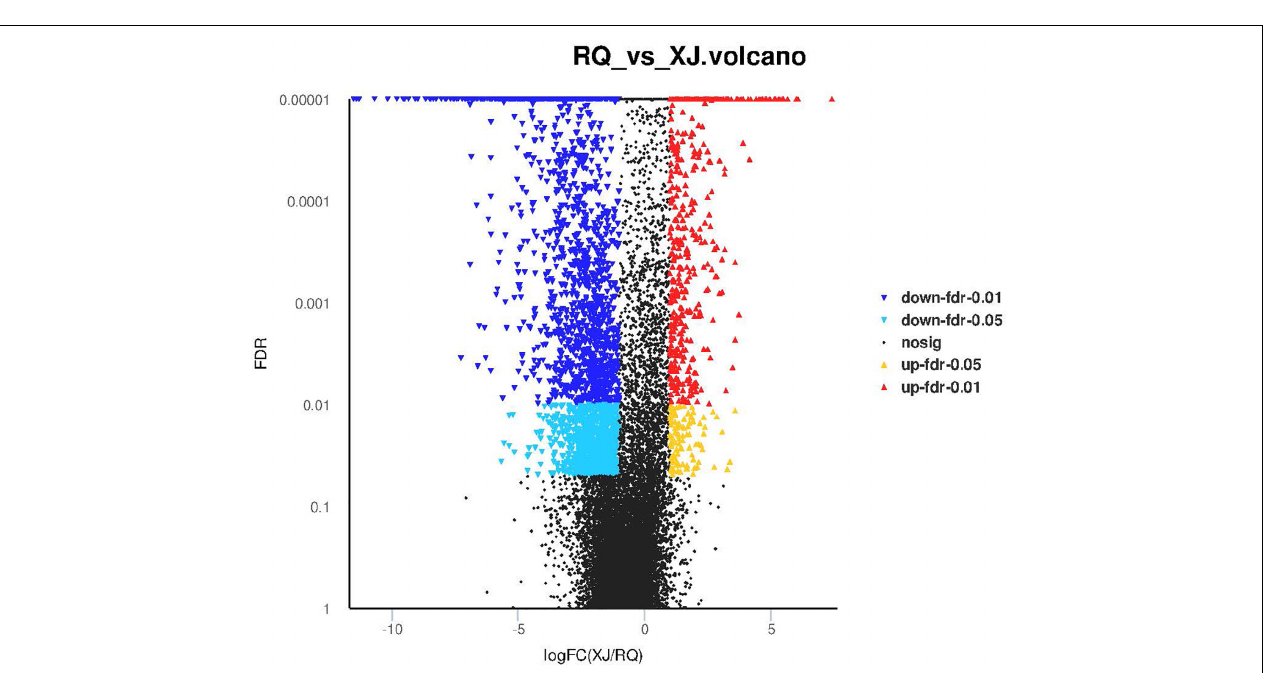
FIGURE 3 | The significant enrichment of DEGs KEGG pathway. The left of the X -axis shows the enrichment ratio, and the right bar shows the P value ( p value is represented by color). * P < 0.05; ** P < 0.01.